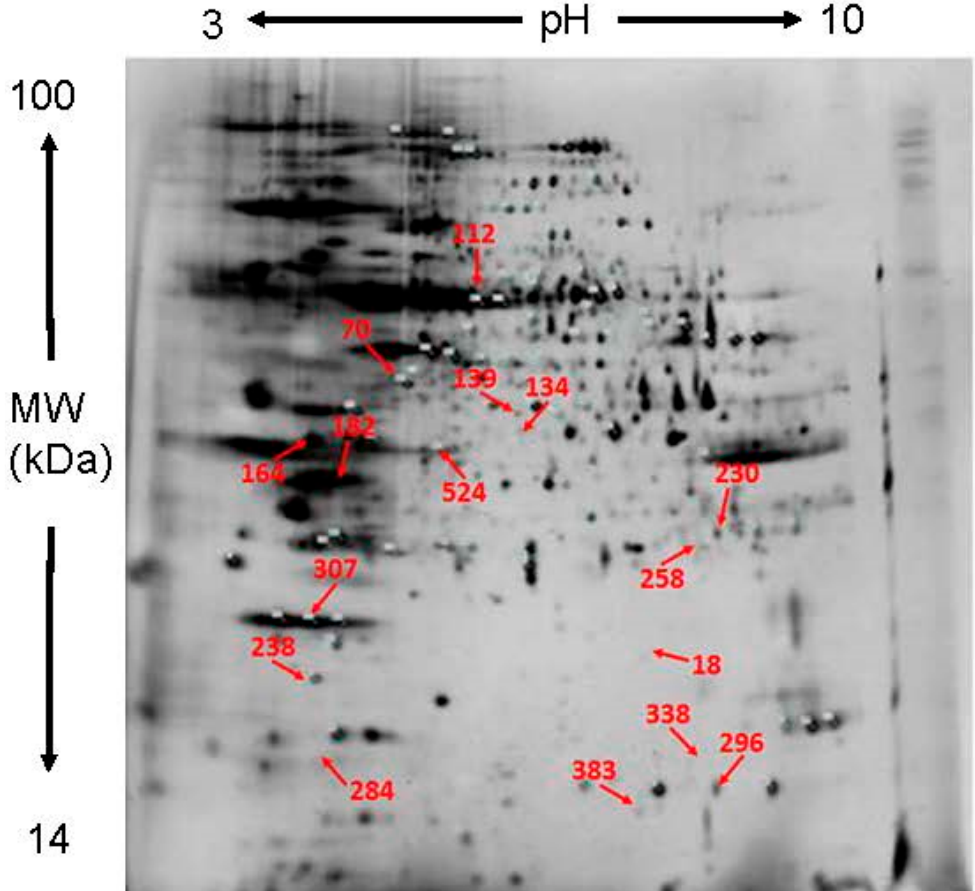
Figure 1. Two-dimensional gel electrophoresis (2-DE) of un-pollinated pistils. Red arrows demonstrate some selected protein spots, which were numbered and collected for identification by matrix-assisted laser desorption/ionization-mass spectrometry (MALDI-MS).